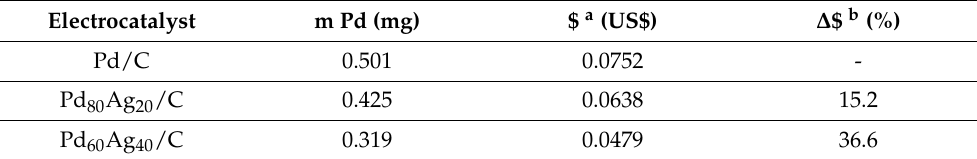
Table 5. Estimated savings for PdAg/C electrocatalysts compared to Pd/C, considering a value of USD 150.00/g of Pd salt *.